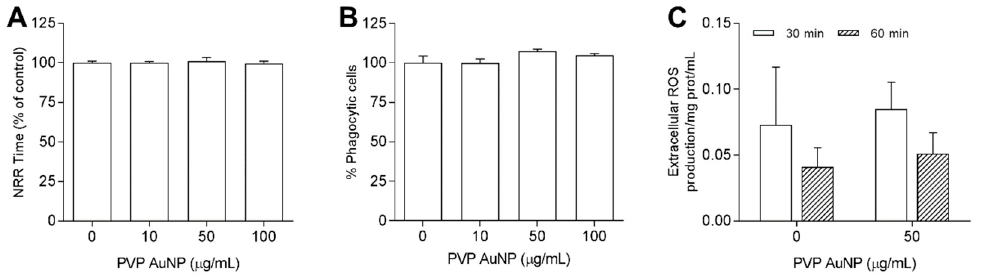
Figure 6. Effects of PVP ‐ AuNPs in ASW on hemocyte: lysosomal membrane stability (LMS) ( A ), phagocytosis ( B ) and extracellular ROS production ( C ).